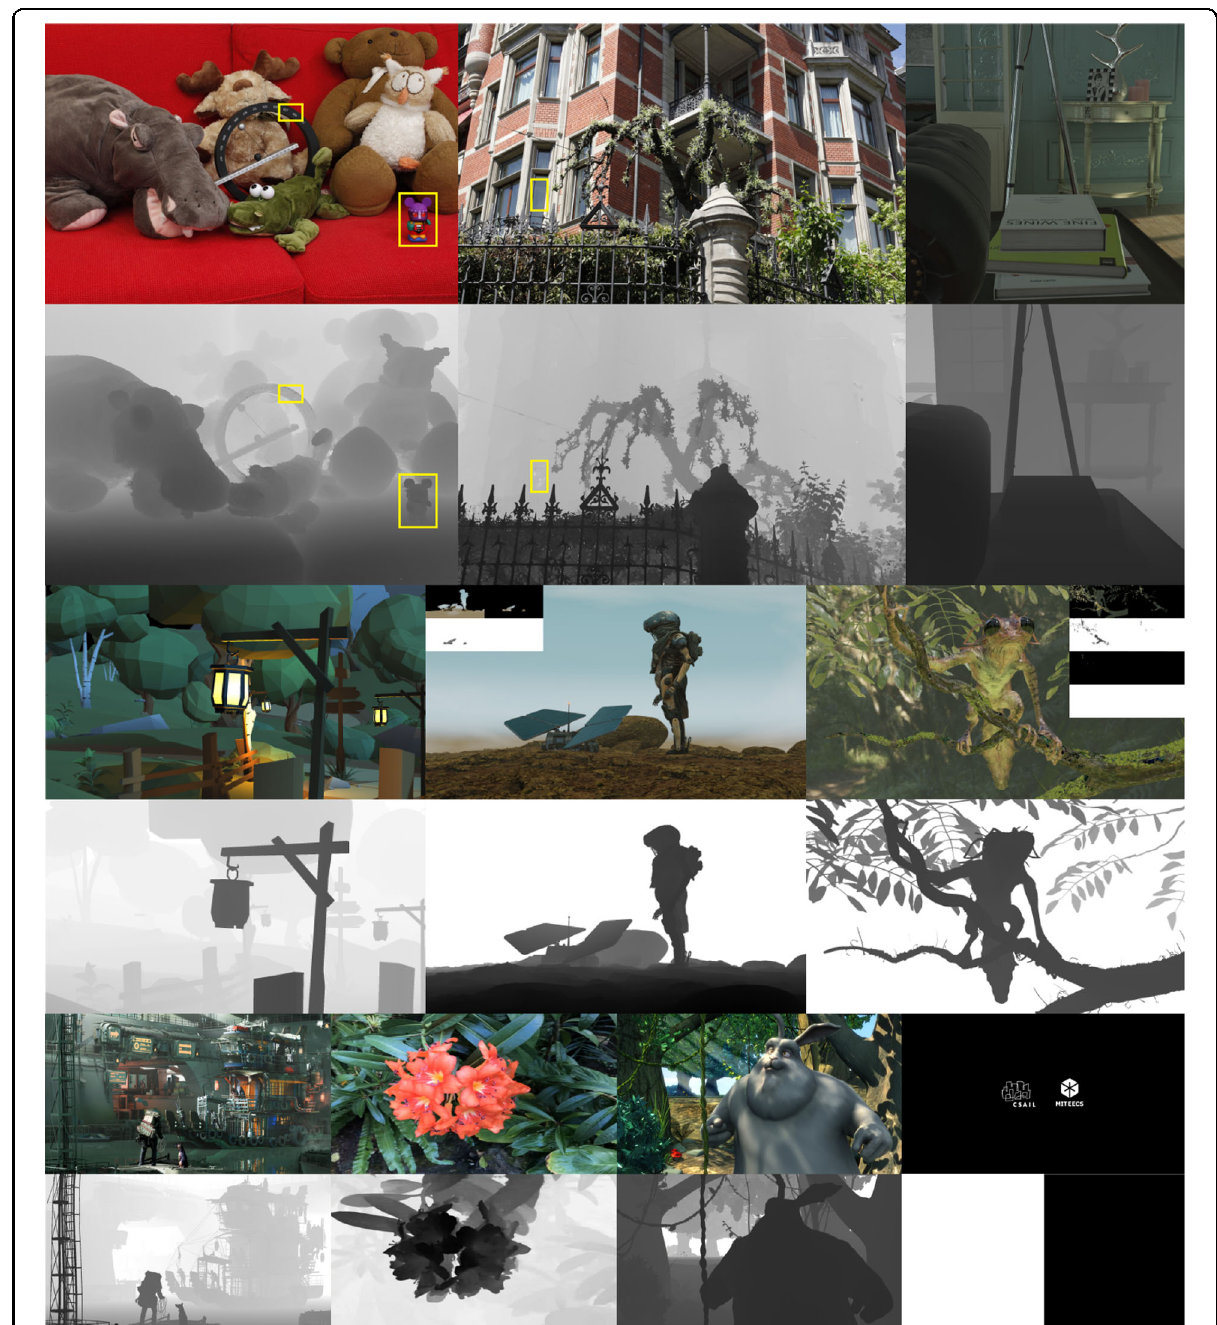
Fig. 10 RGB-D and LDI inputs used in this paper. From top to bottom and left to right: ‘ Couch ’ and ‘ Mansion ’ from Kim et al. 51 , a living room scene from Xiao et al. 52 , a forest scene from Padmanaban et al. 32 , ‘ Wanderer ’ and ‘ Tree Creature ’ by Daniel Bystedt, ‘ PartyTug 6:00AM ’ by Ian Hubert, ‘ Flower ’ from Mildenhall et al. 53 , ‘ Big Buck Bunny ’ by (© 2008, Blender Foundation), and ‘ MIT-EECS-Logo ’ by the authors. ‘ Couch ’ , ‘ Mansion ’ , and ‘ Flower ’ are real-world captured, and the rest are rendered. ‘ Wanderer ’ and ‘ Tree Creature ’ are LDIs and the subsequent layers are visualized at the top corners. The yellow boxes mark the regions with obvious depth misalignment or inconsistency, the soft leave edges in the depth map of ’ Flower ’ are not